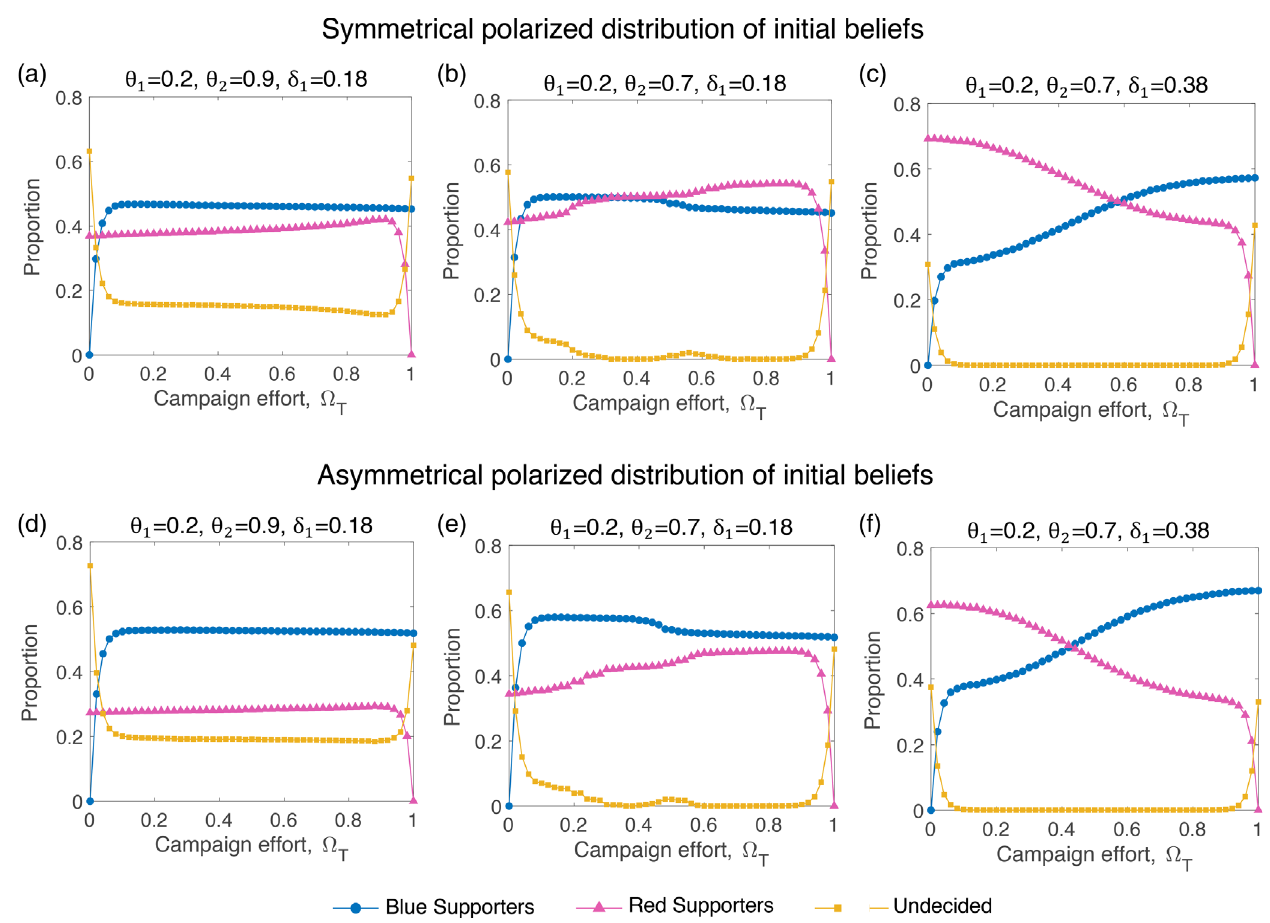
FIG. 13. Impact of campaign effort on winning majority support under polarized initial beliefs. The initial distribution of individual beliefs is relaxed from uniform to a symmetrical bimodal distribution (a) – (c) and an asymmetrical bimodal distribution (d) – (f). The obvious finding that campaigns can suffer if they exert no effort, along with the counterintuitive finding that campaigning slightly too much can also slightly hurt their campaign, both replicate from the original model. Simulation results are averaged over 30 independent runs. Parameters: All simulations begin from an ER graph with N ¼ 10 4 , h k i ¼ 6 , θ 1 ¼ 0 . 2 , θ 2 ¼ 0 . 7 , δ 1 ¼ 0 . 18 , μ 1 ¼ 0 . 5 , and μ 2 ¼ 0 . 5